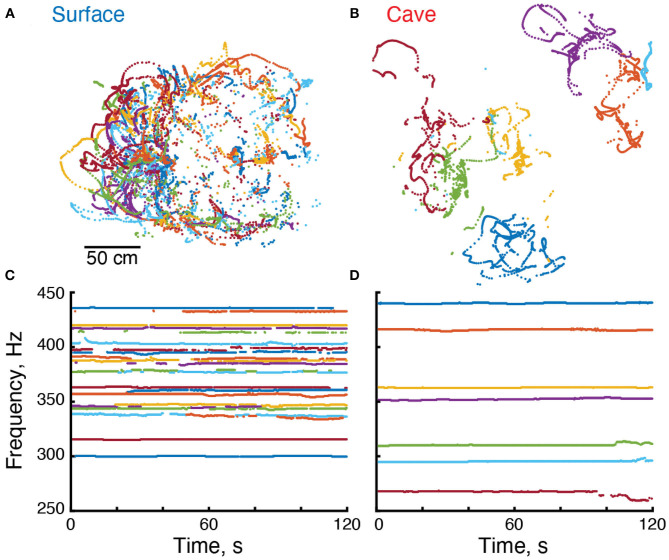
Electrical and locomotor behavior of Eigenmannia. (A,B) Positions of surface and cave Eigenmannia over a period of 120 s. (C,D) EOD frequencies of these fish. Each color represents a unique fish in each recording.